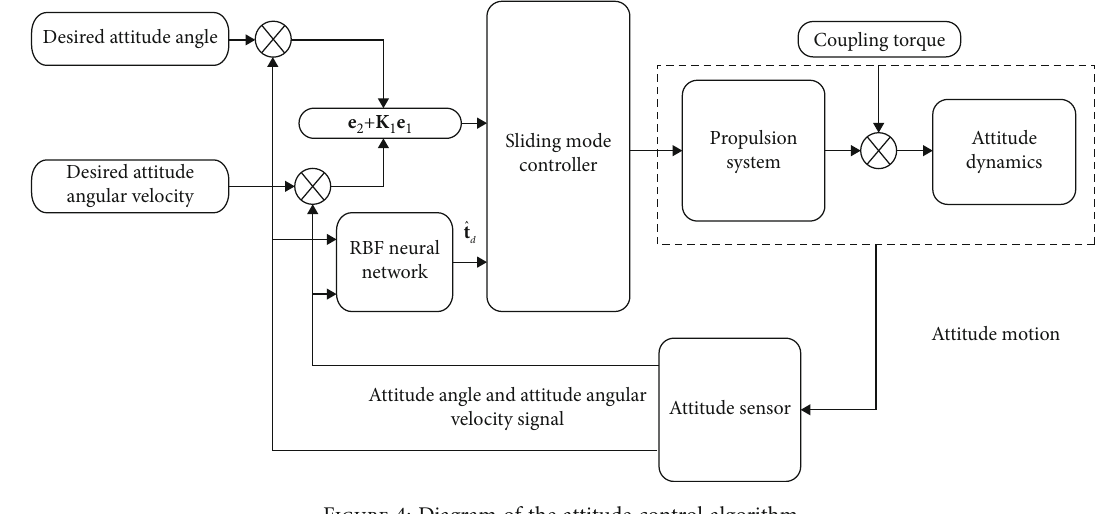
Figure 4: Diagram of the attitude control algorithm. Table 1: Deviation parameters of the propulsion system.